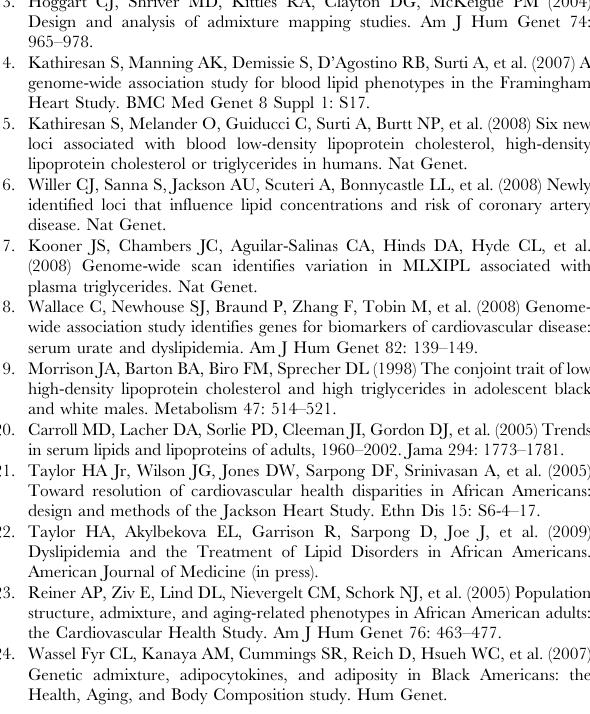
Figure S1 Average Cases-Only LOD Scores Across the Genome for a) TG, b) HDL-C, and c) LDL-C. The risk model specified is for a 1.5-fold increased risk of Case status with inheritance of a single copy of the i) African or ii) European ancestral allele.